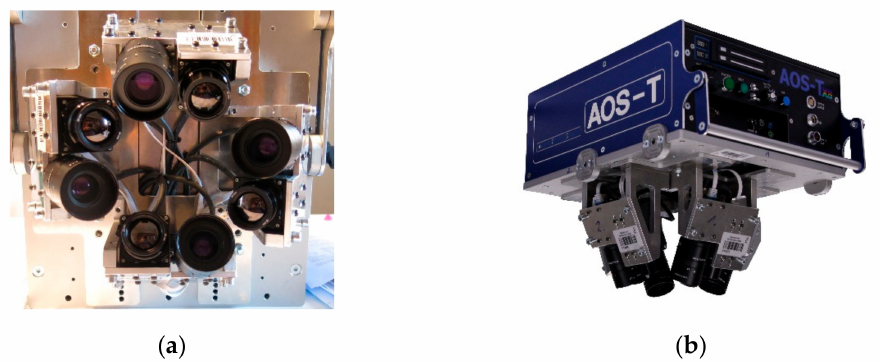
Figure 1. The AOS-Tx8 block configuration. ( a ) Picture of the four RGB cameras and four thermal cameras and ( b ) picture of the whole